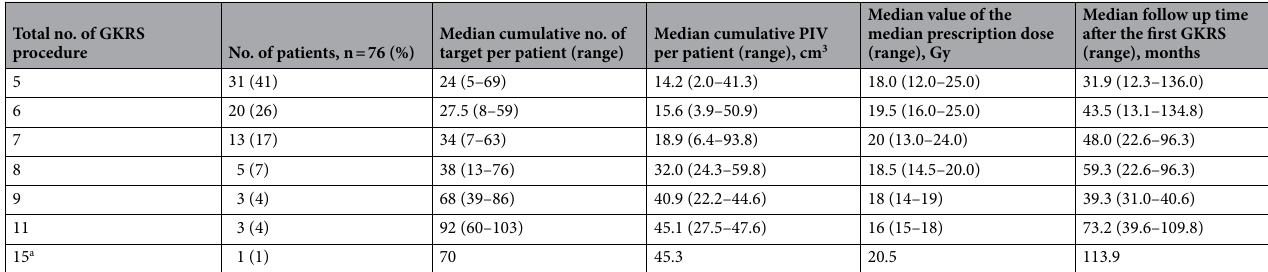
Table 3. Parameters of radiosurgery. GKRS gamma knife radiosurgery, PIV prescription isodose volume. a Data from the 9th GKRS session were